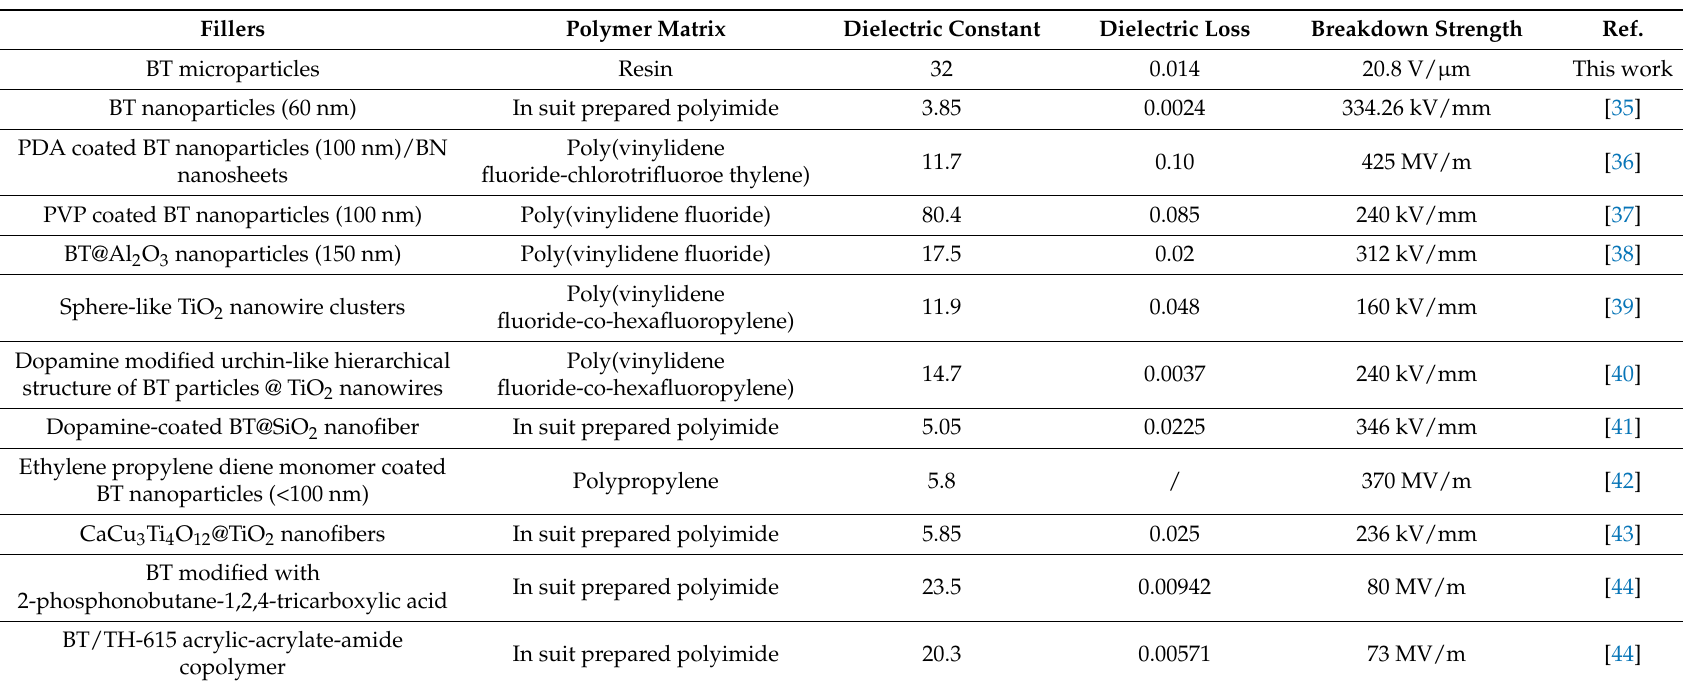
Table 1. Comparisons of dielectric constant, dielectric loss and breakdown strength of the composites containing BT particles.